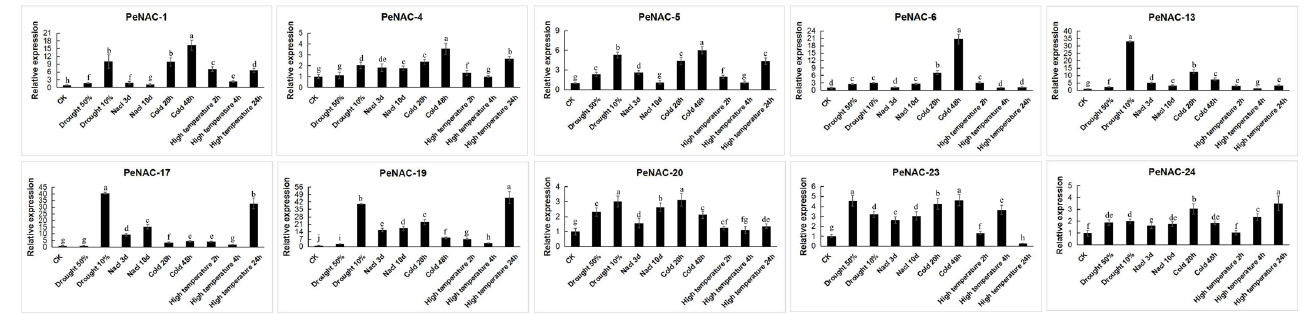
Figure 3. Expression analysis of 10 PeNACs under different abiotic stresses in the passion fruit. The experimental materials are identical to those used for RNA-seq under the abiotic stresses. The details are shown in Table S2. Data are means ± SD of n = 3 biological replicates. Means denoted by the same letter are not significantly different at p < 0.05 as determined by Duncan’s multiple range test.